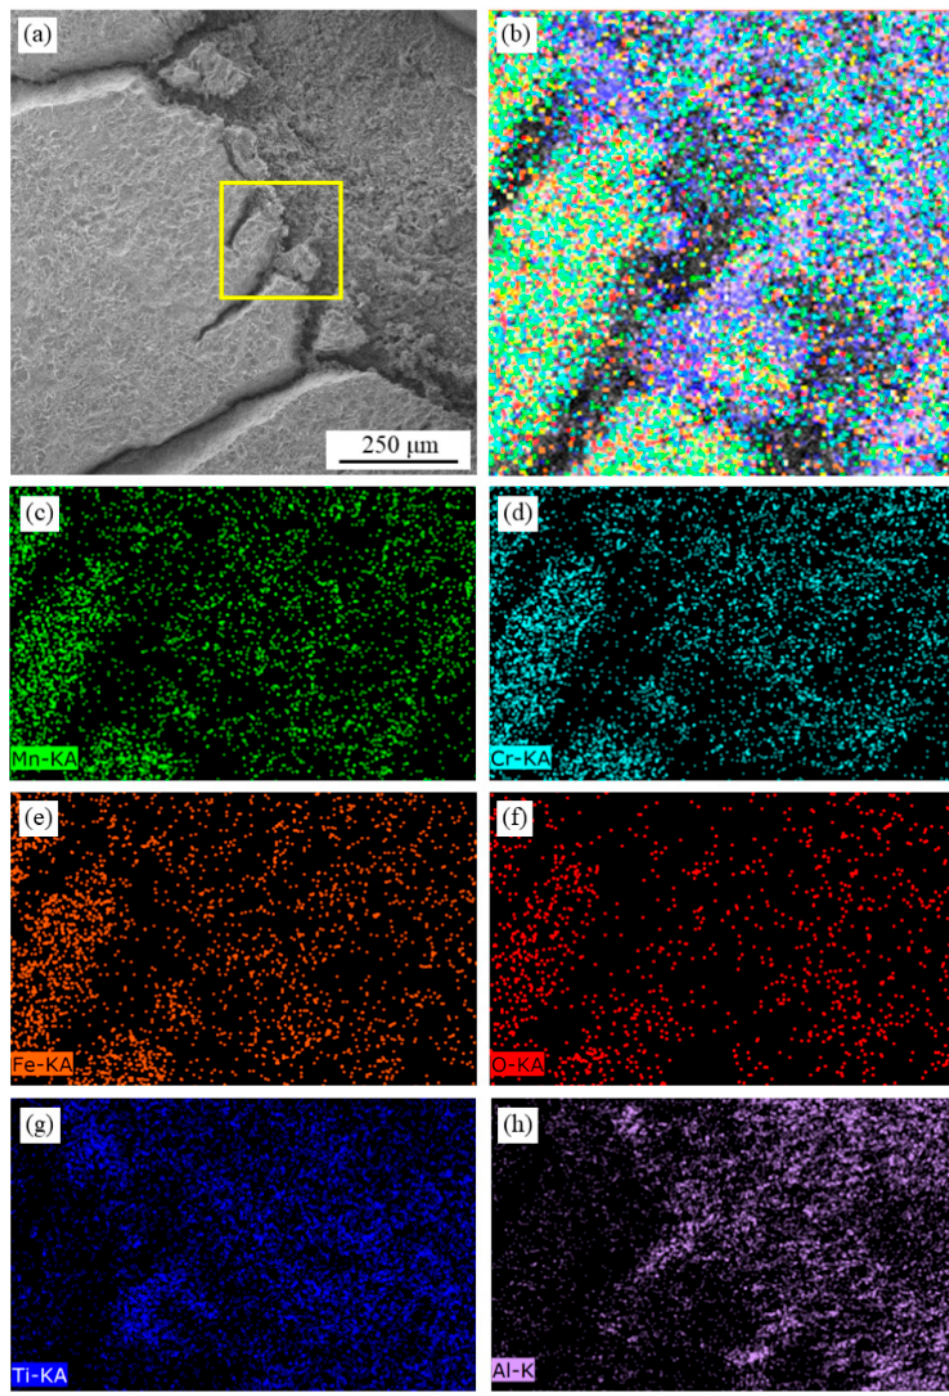
Figure 10. EDX analysis of Al 10 Cr 30 Fe 25 Mn 30 Ti 5 HEA in 2.5 M NaOH after the CPP: ( a ) SEM micro ‐ graph ×120, ( b ) EDX mapping, and EDX mapping of ( c ) Mn, ( d ) Cr, ( e ) Fe, ( f ) O, ( g ) Ti, and ( h ) Al.